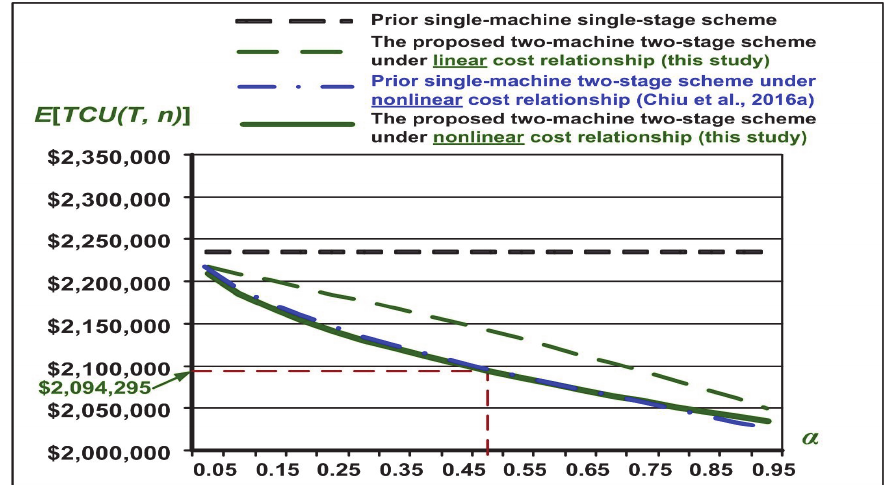
Fig. 9 . Performance of E[ TCU ( T, n )] relating to α for both nonlinear and linear cases